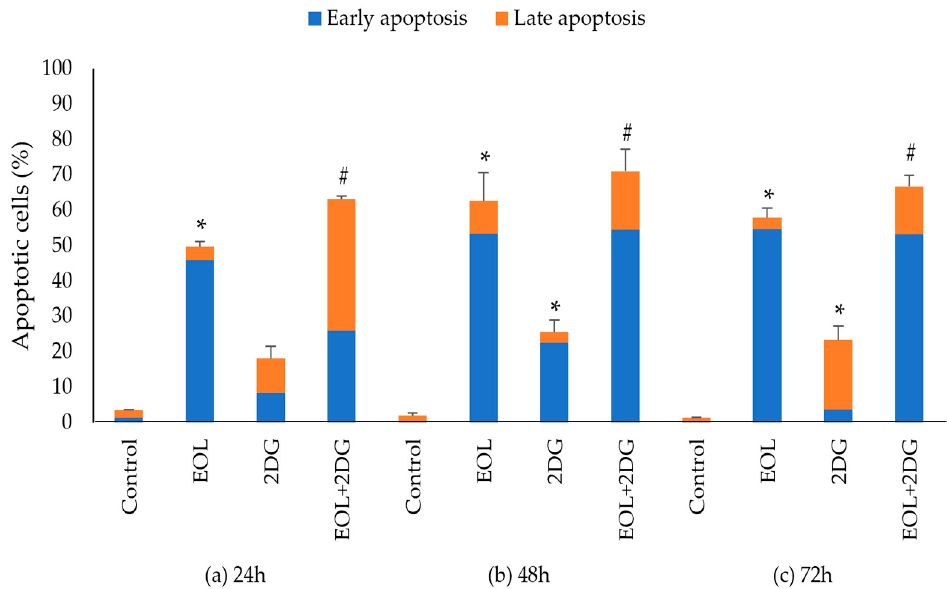
Figure 11. Induction of apoptosis in PANC-1 cells at ( a ) 24 h, ( b ) 48 h and ( c ) 72 h. The data were shown as the mean values ± S.D. for three independent experiments, and the statistical analysis was determined using a Student’s t -test, with the * symbol showing a significant difference ( p < 0.05) in comparison to control untreated cells and the # symbol showing a significant difference ( p < 0.05) in comparison to 2-DG.